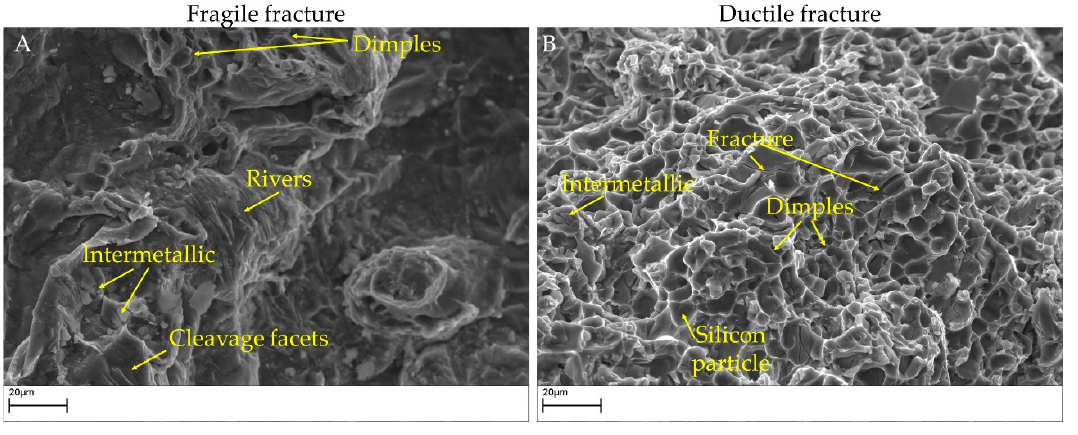
Figure 11. SEM images of fracture surfaces in impact specimens. ( A ): A brittle fracture in alloy 4 modified (impact energy 3.17 J). ( B ): A ductile fracture in alloy 3 modified (impact energy 8.82 J).